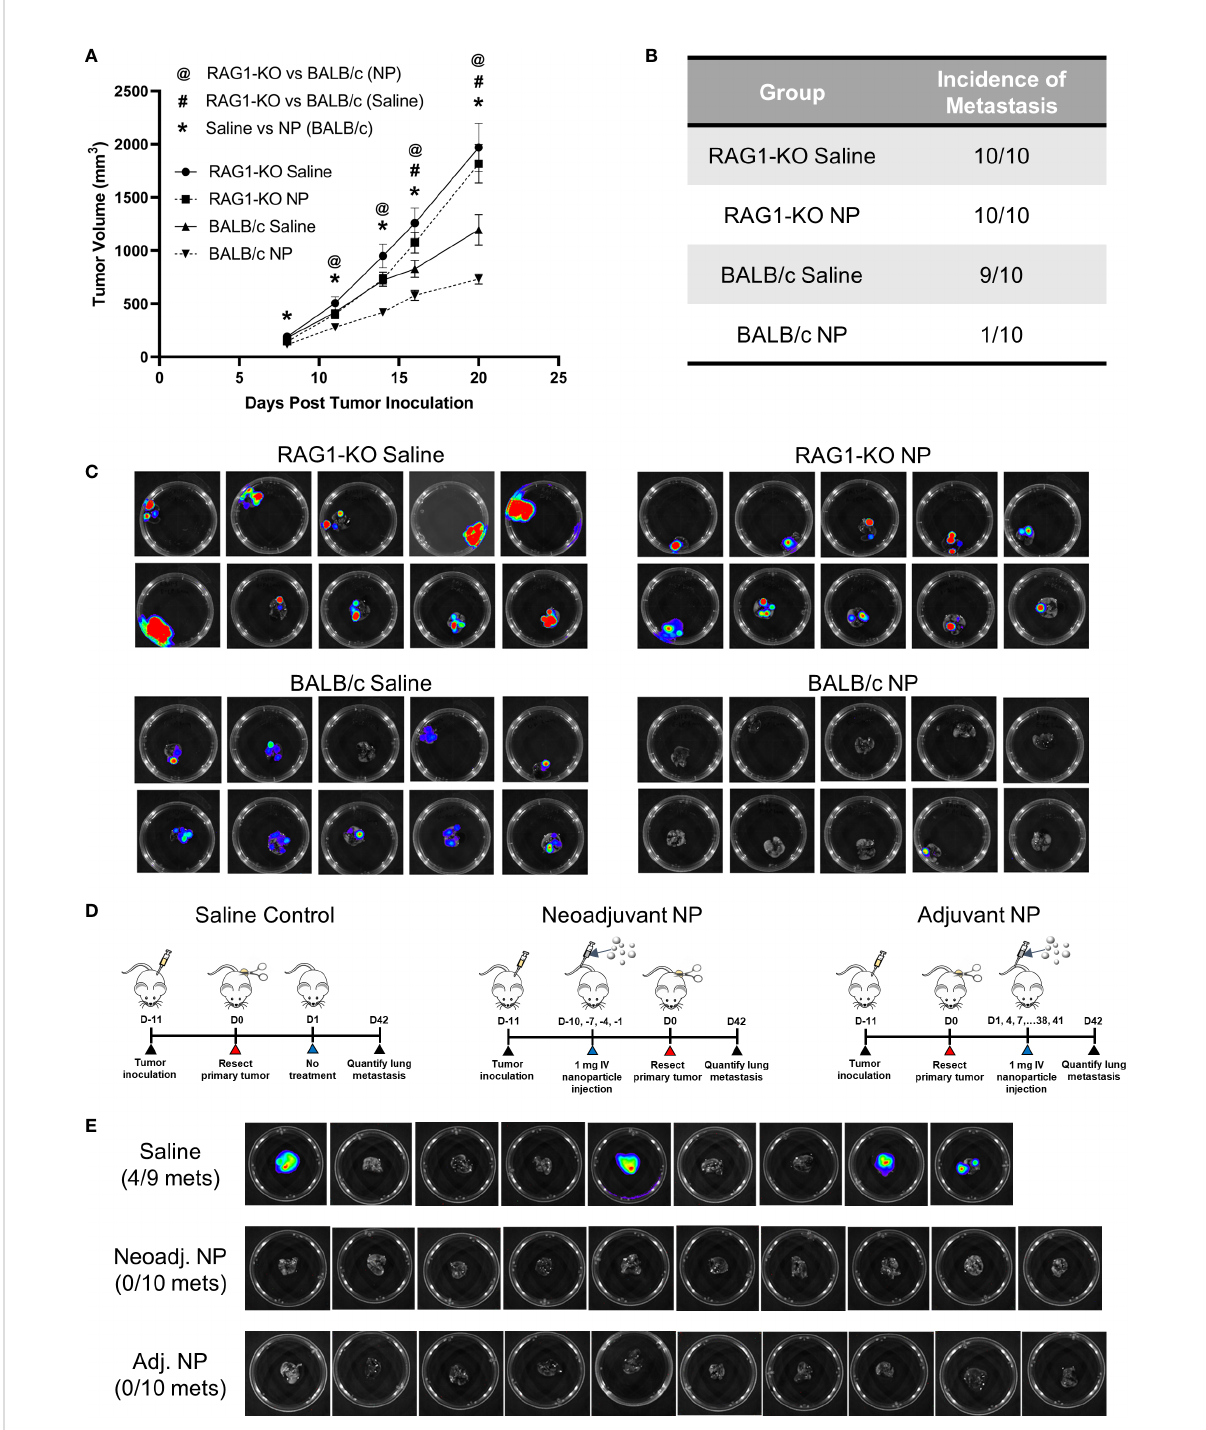
FIGURE 5 The NP-mediated clearance of metastatic tumors in vivo is dependent on functional T-cells. (A) Longitudinal PT growth in 4T1-bearing BALB/c or RAG1-KO mice receiving saline or NPs (n=10 per group). (B) Proportion of BALB/c versus RAG1-KO mice with pulmonary metastases at D21 post-tumor inoculation and (C) BLI of the lungs. (D) Schematic of PT resection model and treatment. NPs were administered either before (neoadjuvant) or after (adjuvant) PT resection. (E) Lung BLI of BALB/c mice receiving NPs or saline (n=9-10 per group) in PT resection study. Two-tailed unpaired t-tests assuming unequal variance were performed for single comparisons between two conditions. Statistically signi fi cant differences in PT growth (p < 0.05): RAG1-KO NP vs BALB/c NP (@), RAG1-KO saline vs BALB/c saline (#), and BALB/c NP vs BALB/c saline